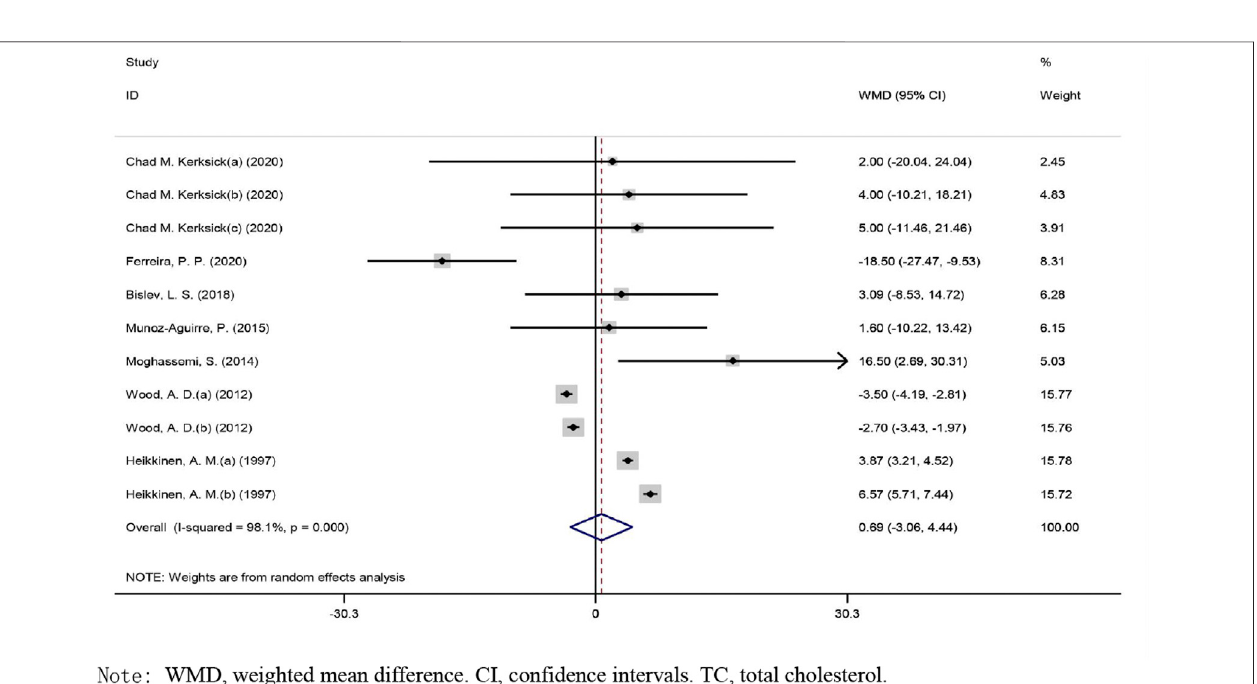
Frontiers in Molecular Biosciences |